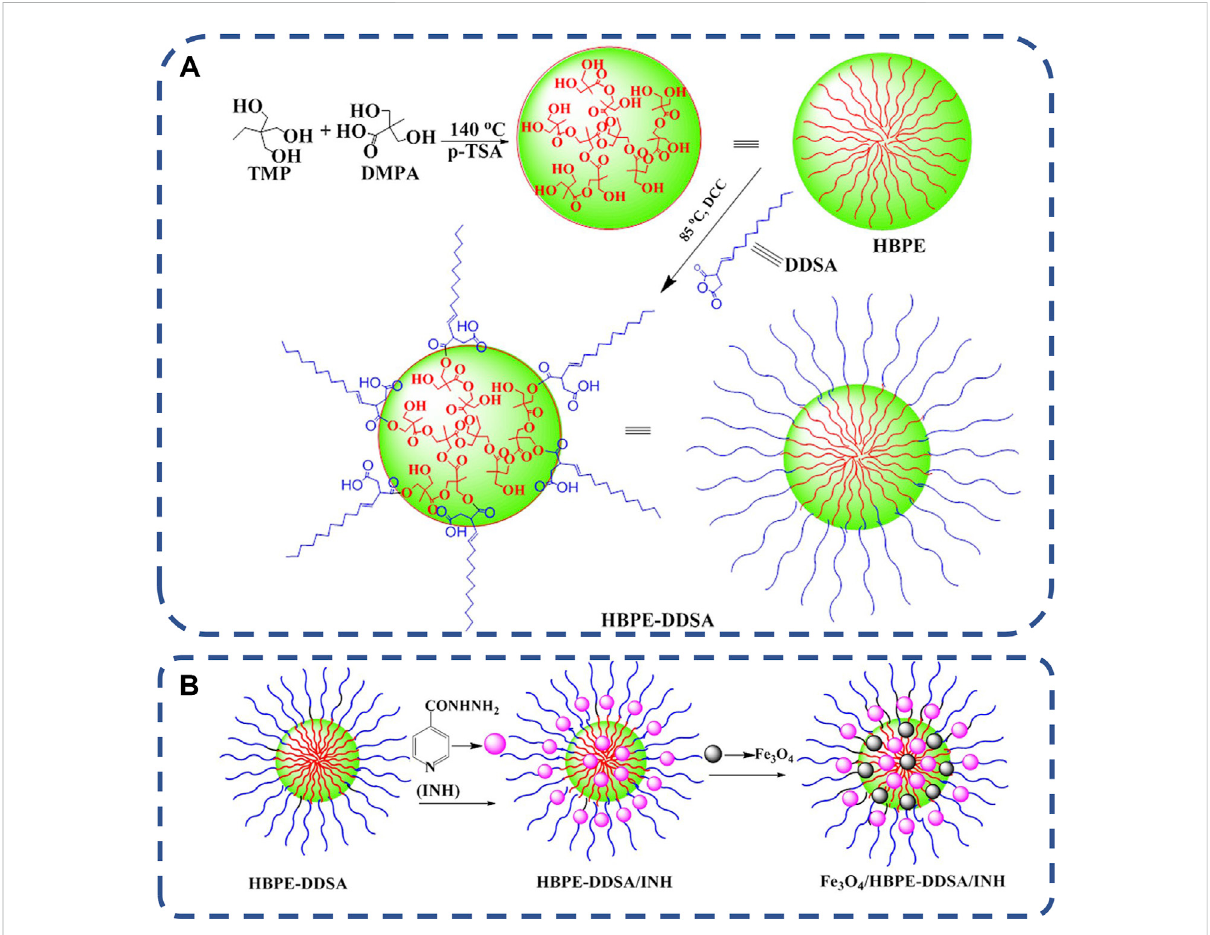
FIGURE 7 (A) Synthetic route of HBPE-DDSA. (B) The formation of the nanocomposites of HBPE-DDSA/INH and Fe3O4/HBPE-DDSA/INH (Zhao et al., 2017).Copyright 2017, J Biomater Sci Polym